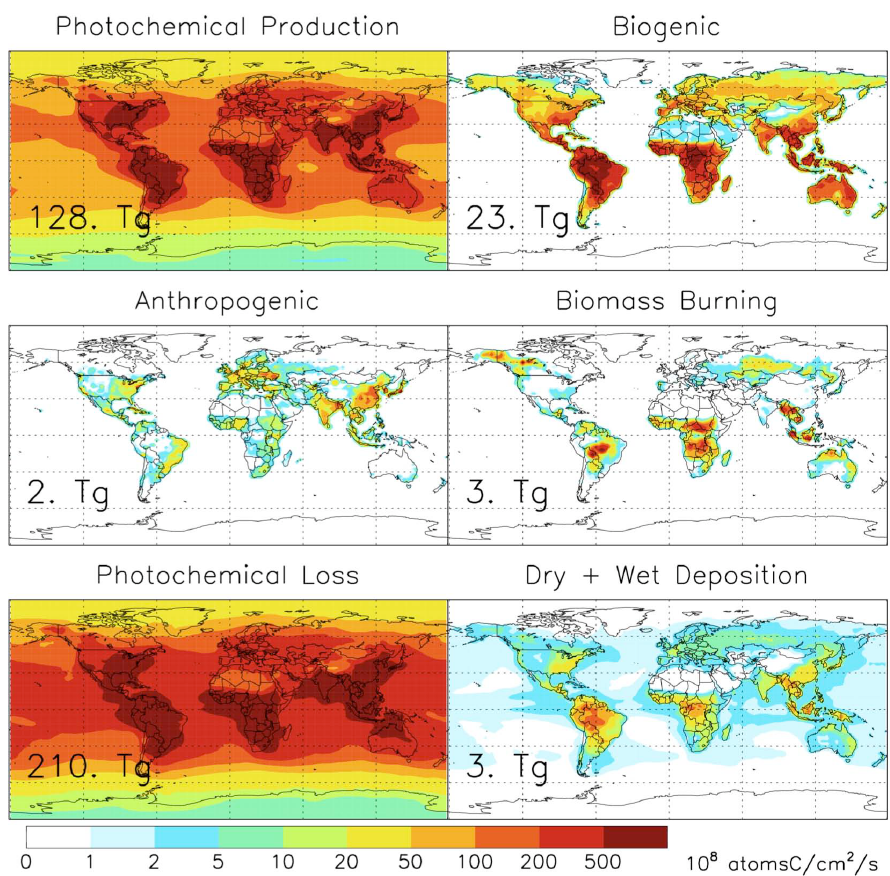
Fig. 1. Annual average sources and sinks of acetaldehyde in GEOS-Chem. Shown are photochemical production, biogenic emis- sions from live and decaying plants, anthropogenic emissions (urban/industrial+biofuel), biomass burning emissions, photochemical loss (OH+photolysis), and deposition. Net ocean exchange is shown separately in Fig.